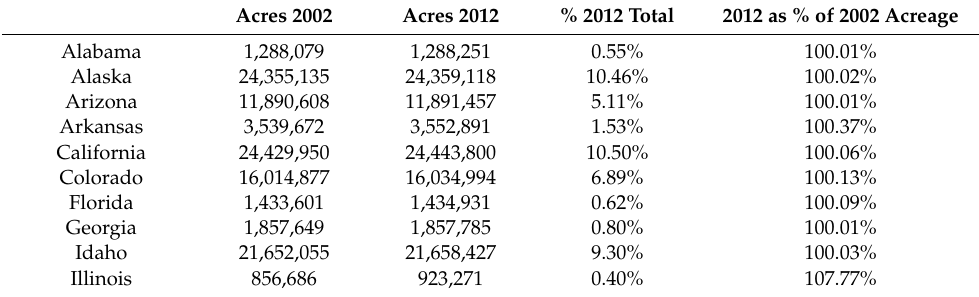
Table 2. USFS acreage data and percentage by state in 2002 and 2012. Source: United States Forest Service